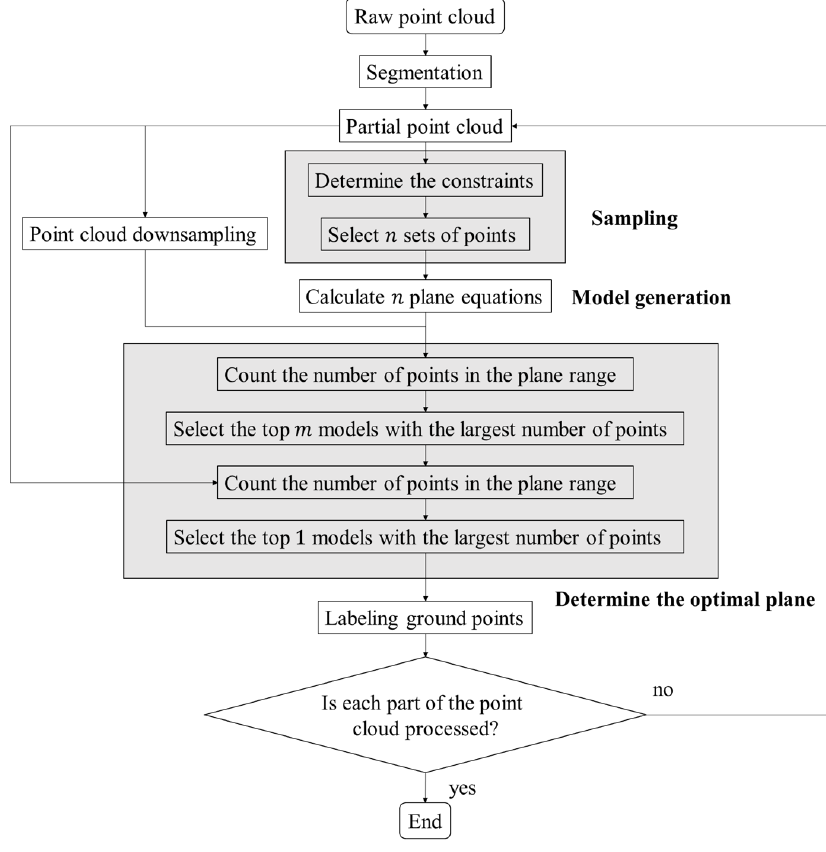
Figure 2. Flowchart of the proposed